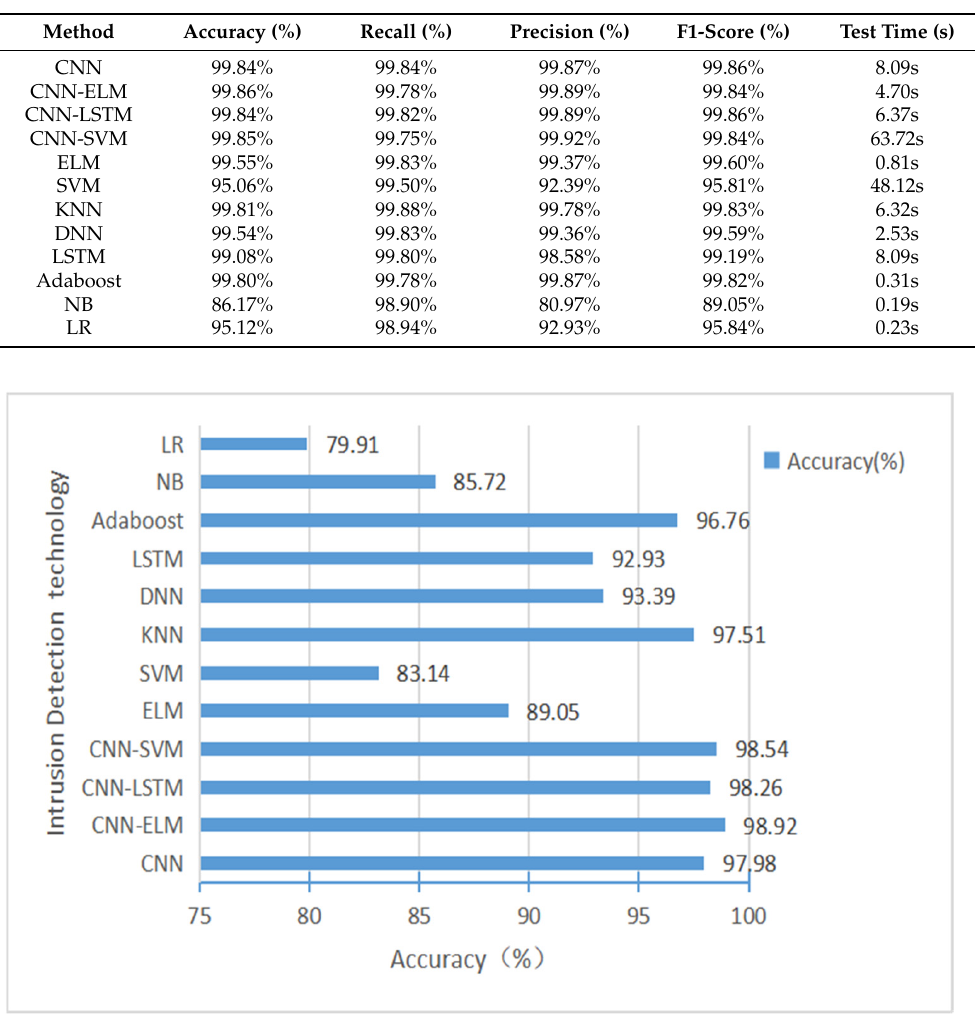
Figure 7. The accuracy comparison of CNN-ELM hybrid models based on the results of 12 subsets of features in the CICIDS-2017 dataset